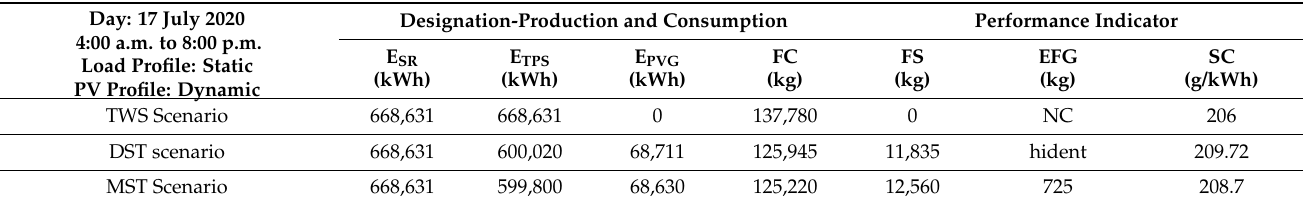
Table 6. Summary of fuel consumption mixed scenario QSP and DSP (Day: 17 July